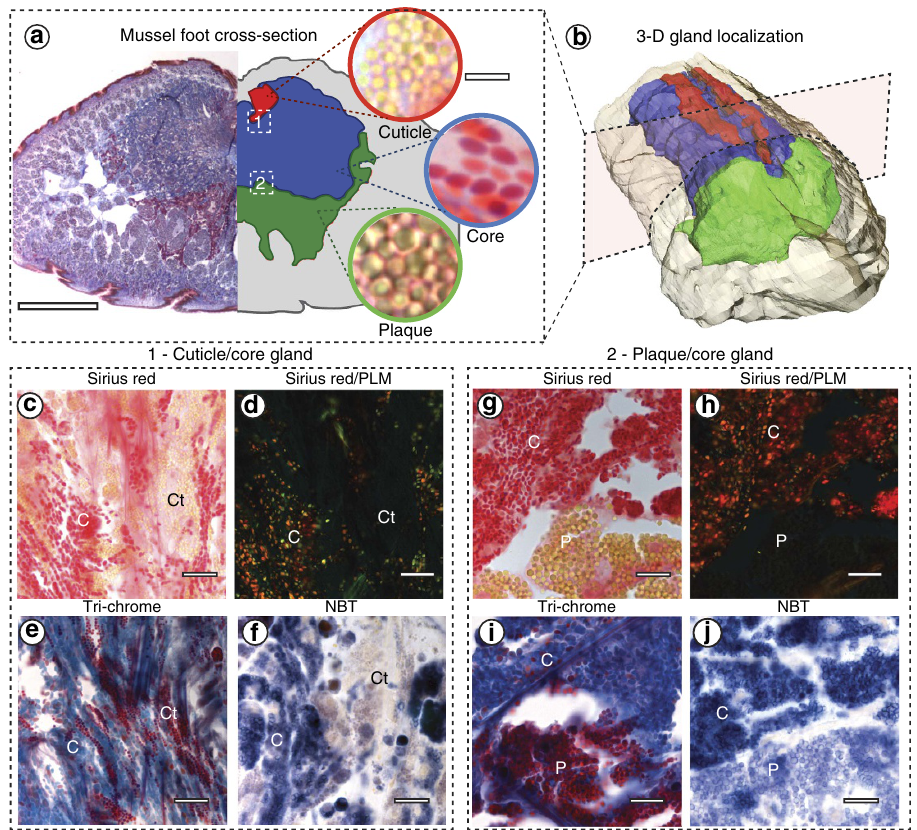
Figure 2 | Histological investigation of mussel foot secretory glands. ( a ) Trichrome stained transverse cross-section of the mussel foot tissue (left; scale bar, 1mm) and accompanying colour-coded illustration showing localization of the three secretory glands (right). High magnification light microscopy images of the vesicles in each gland are shown on the far right (scale bar, 3 m m for all three images). ( b ) 3D reconstruction of a mussel foot in the resting state made from serial trichrome stained transverse foot sections showing gland distribution using the same colour scheme shown in a . The colour scheme is arbitrary and is used throughout the paper to identify the specific glands and their contents. ( c – j ) Microscopy images of histologically stained mussel foot sections from regions approximately indicated by the numbered white dashed boxes in a . Panels c – f show regions from the interface between the cuticle (Ct) and core (C) glands (box 1), while panels g – j show regions from interface of the plaque (P) and core (C) glands (box 2). ( c , g ) Sirius red stains collagen bright red. ( d , h ) PLM imaging of the same region in c and g , respectively, showing the birefringence of the vesicles in the core gland indicating collagen alignment. ( e , i ) Masson’s trichrome stains the core gland vesicles blue indicating presence of collagen, whereas the cuticle and plaque vesicles are stained red. ( f , j ) Positive, purple-blue coloration with NBT-glycinate staining indicates the presence of oxidized DOPA groups (that is, DOPA-quinone). Scale bars for c – j are 10 m